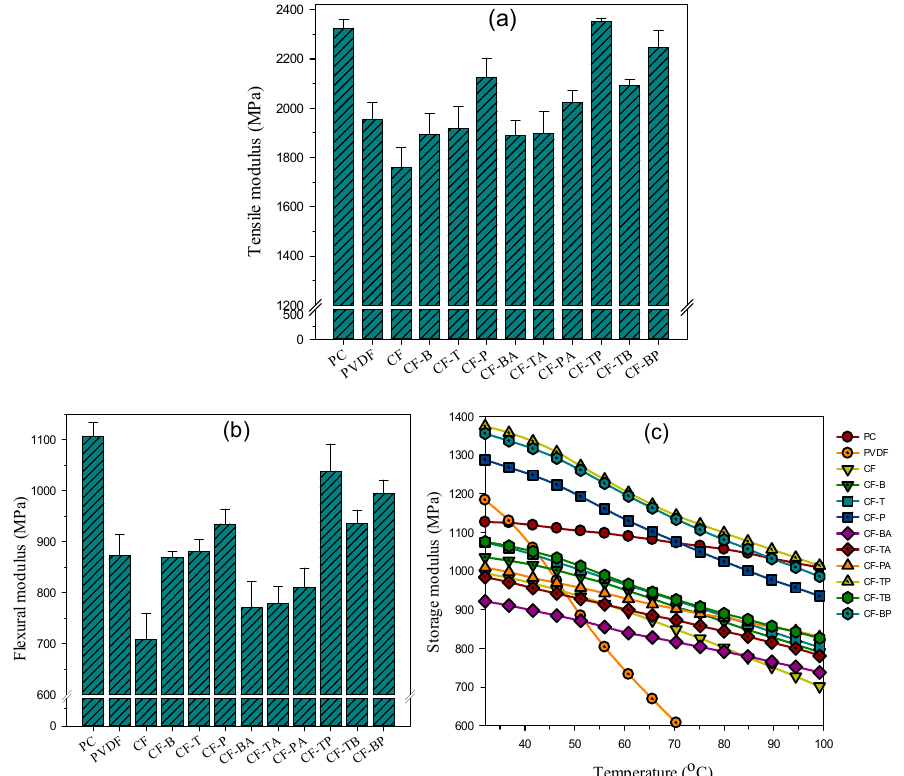
Figure 7. ( a ) Tensile modulus, ( b ) flexural modulus, and ( c ) storage modulus of prepared sam-